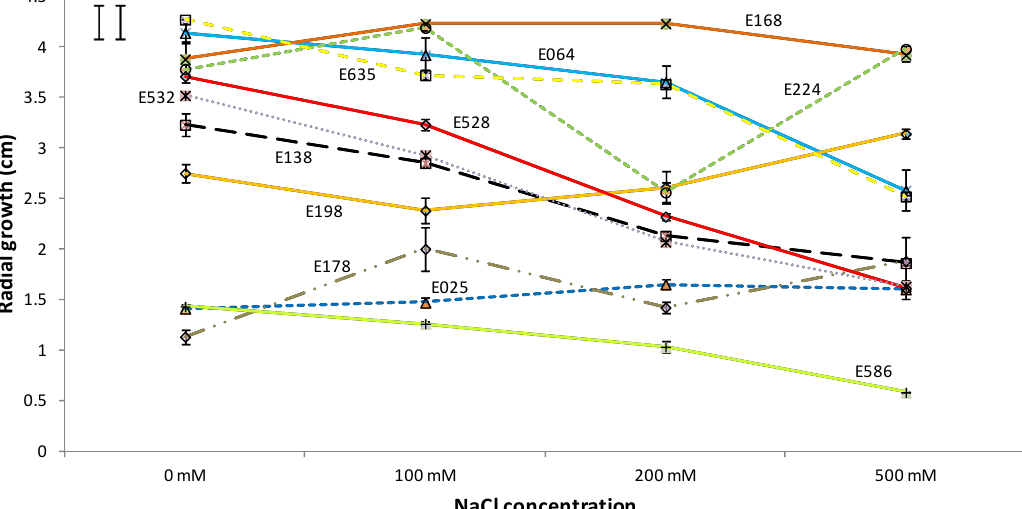
Figure 2. Influence of the NaCl concentration on the radial growth of the studied endophytes after 9 days of incubation. The results are given as mean ± standard error (n = 3). The least significant difference (LSD) of the salt concentration*isolate interaction is shown in the upper left corner (critical value for comparison of the same and different levels of salt are shown as left and right bars, respectively).